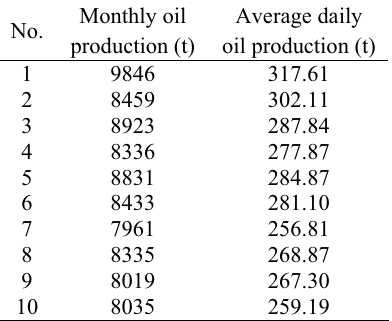
Table 2. Part of oil production data